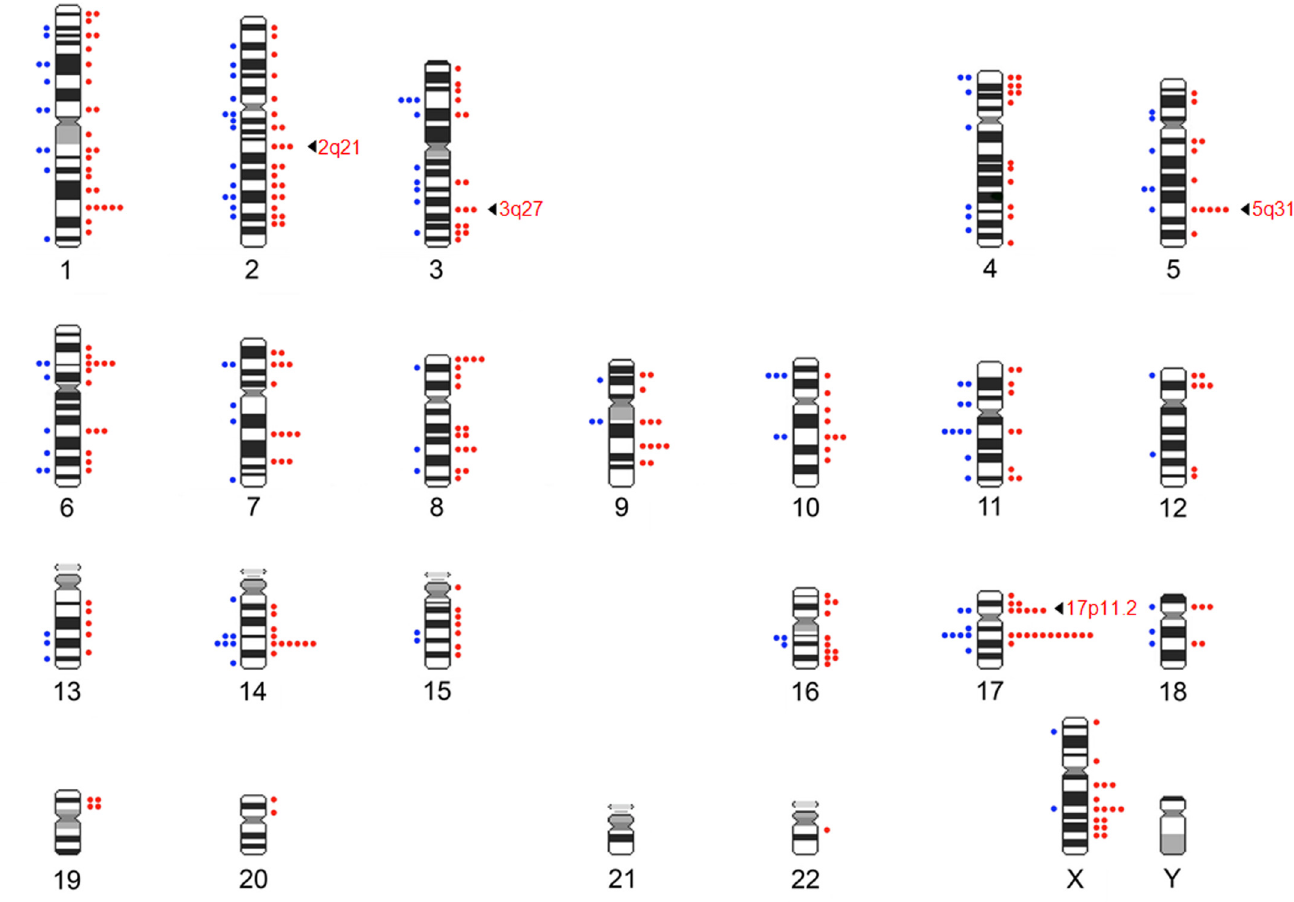
Fig 2. Distribution of breakpoints observed in lymphocytes metaphases from exposed to oil (right) and non-exposed (left) individuals in the human ideogram (400-band resolution). The most affected bands only in exposed are indicated by arrows.